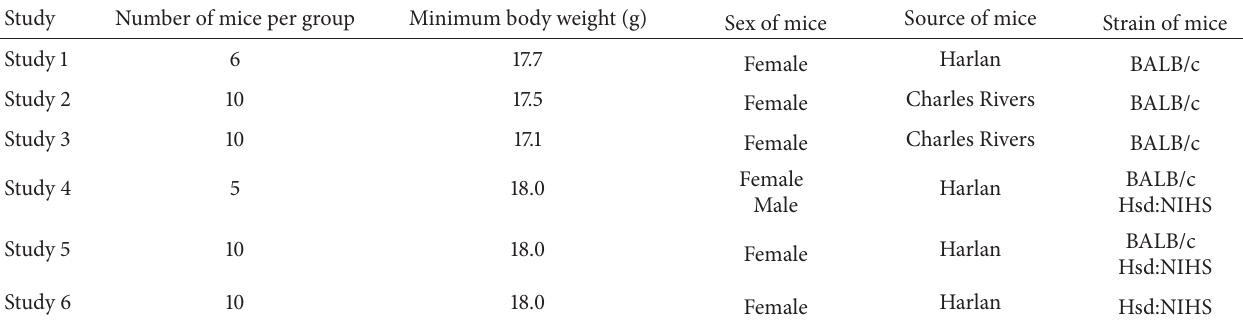
Table 2: A tabular summary of the murine data for each of the challenge experiments